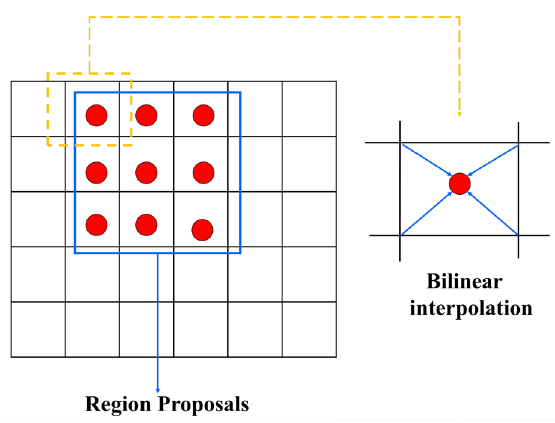
Figure 8. Bilinear Interpolation. Figure 8. Bilinear